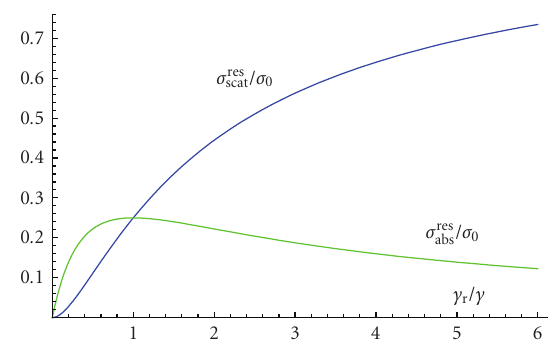
Figure 1: σ res and σ res as functions of γ r /γ in the resonance (cid:2) ω 0 = ω l . scat abs σ 0 = (3 / 2 π ) λ 2 l